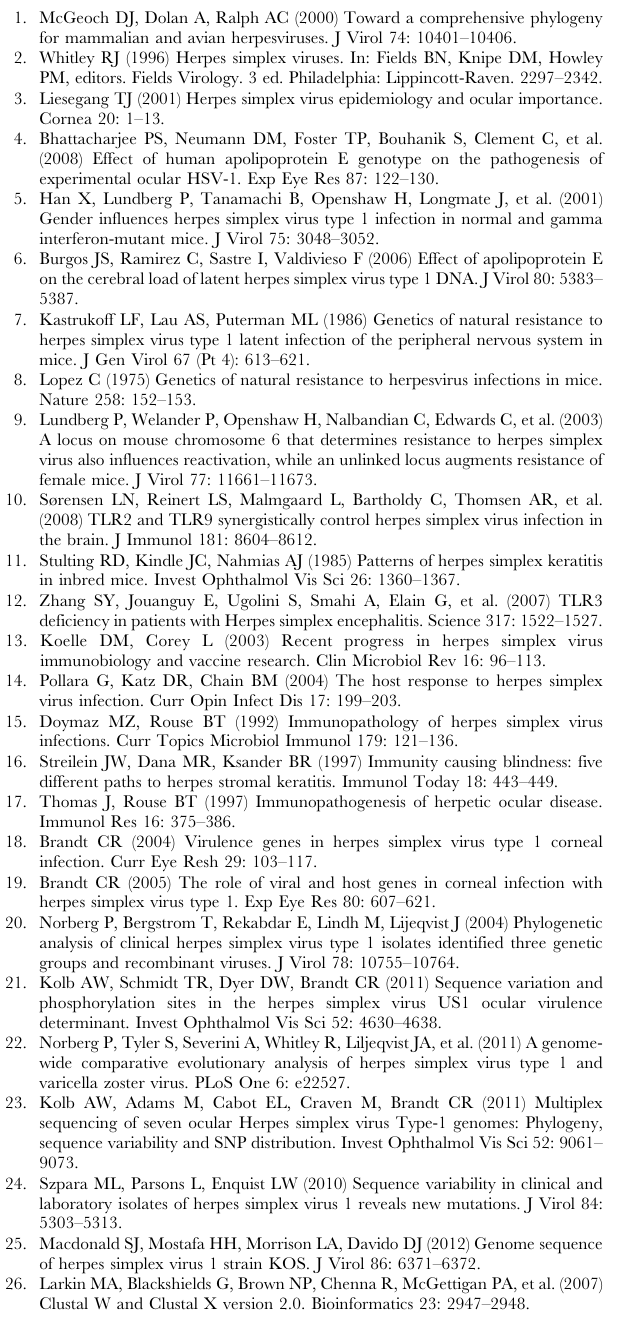
Figure S1 Consensus trees (70% threshold value) for each of 5 kb partitioning of the genomic alignment. (TIF)